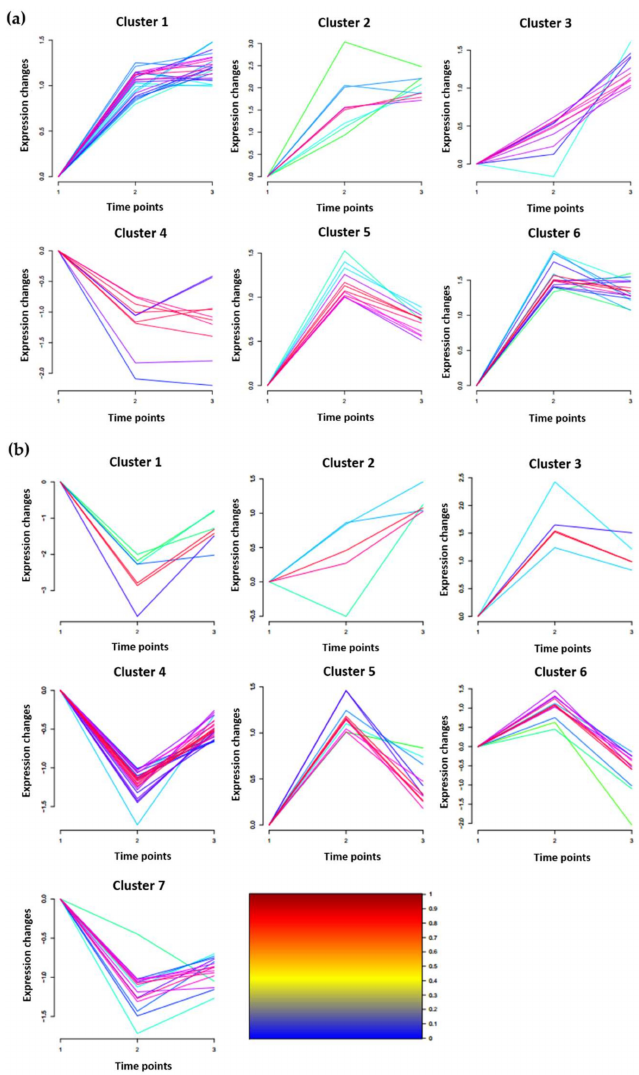
Figure 5. MFUZZ clustering analysis of DRPPs unique to Chang7-2 ( a ) and Zheng58 ( b